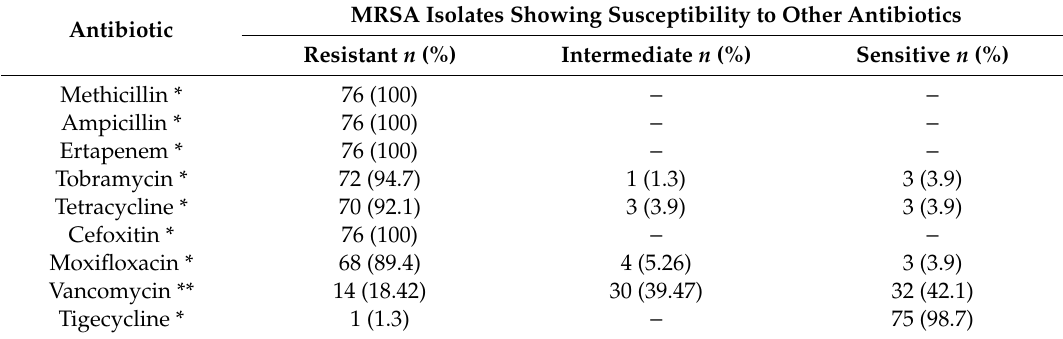
Table 2. Antibiotic Susceptibility pattern of methicillin-resistant Staphylococcus aureus (MRSA) ( n = 76).